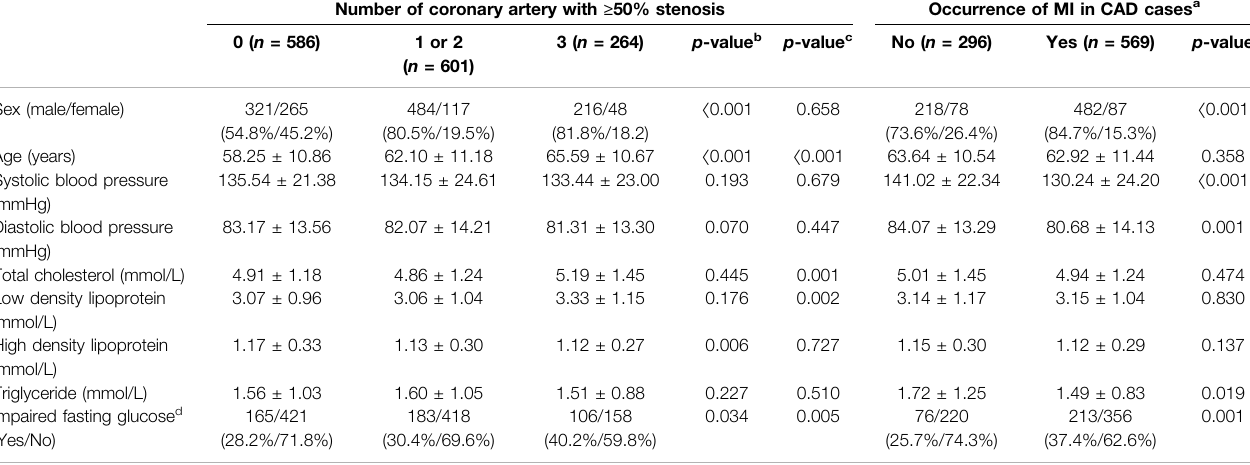
TABLE 1 | Demographic and clinical characteristics of study subjects.